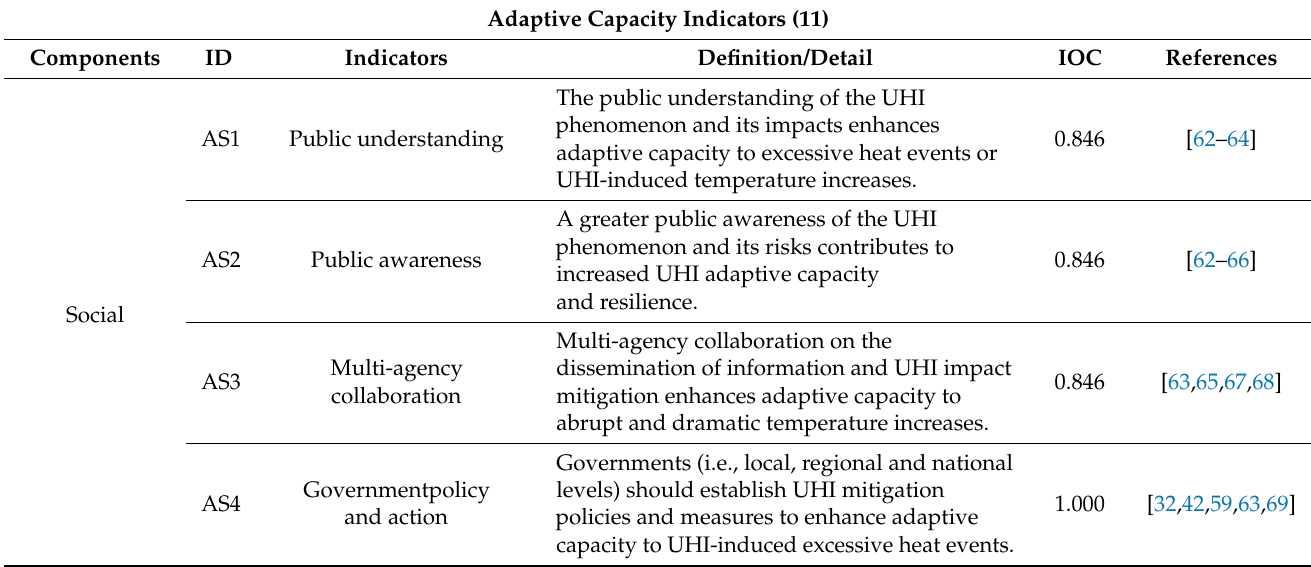
Table 4. The UHI adaptive capacity indicators, definitions and expert-validated IOC